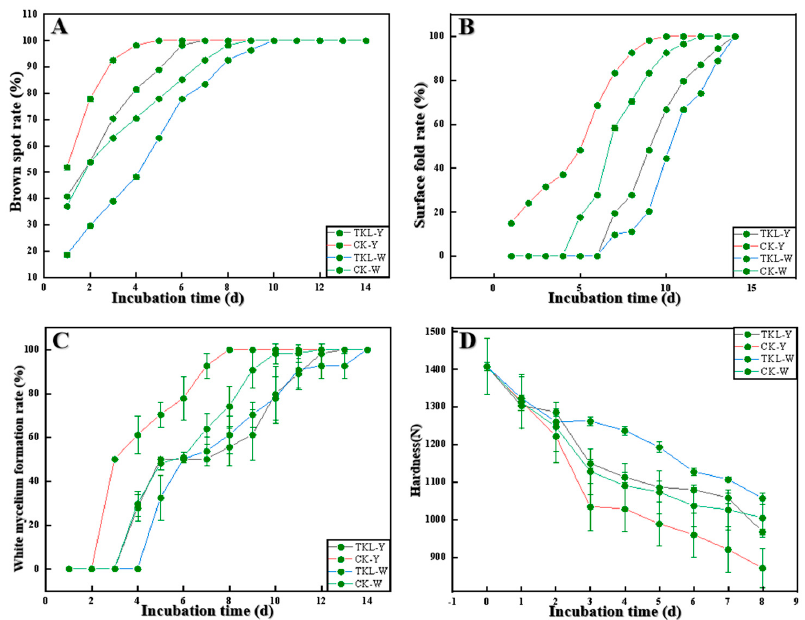
Figure 6. The rate of brown spots of okra in four groups was changed at 28 °C for 0 – 14 days ( A ), the rate of the surface fold of okra in four groups ( B ), the rate of white hyphae formation of okra in four groups ( C ), and the hardness changes of okra in four groups ( D ).